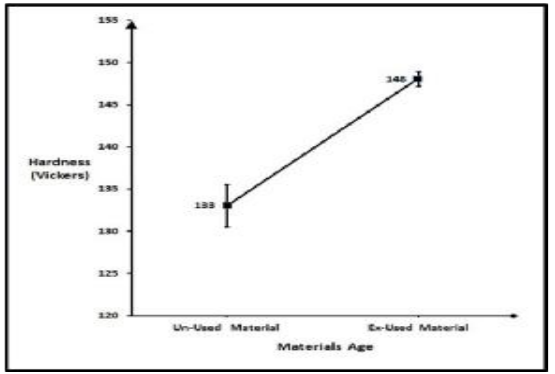
Fig. 3. Comparison between hardness of un-used and ex-used tubes of stainless steel material A- 312TP321H .